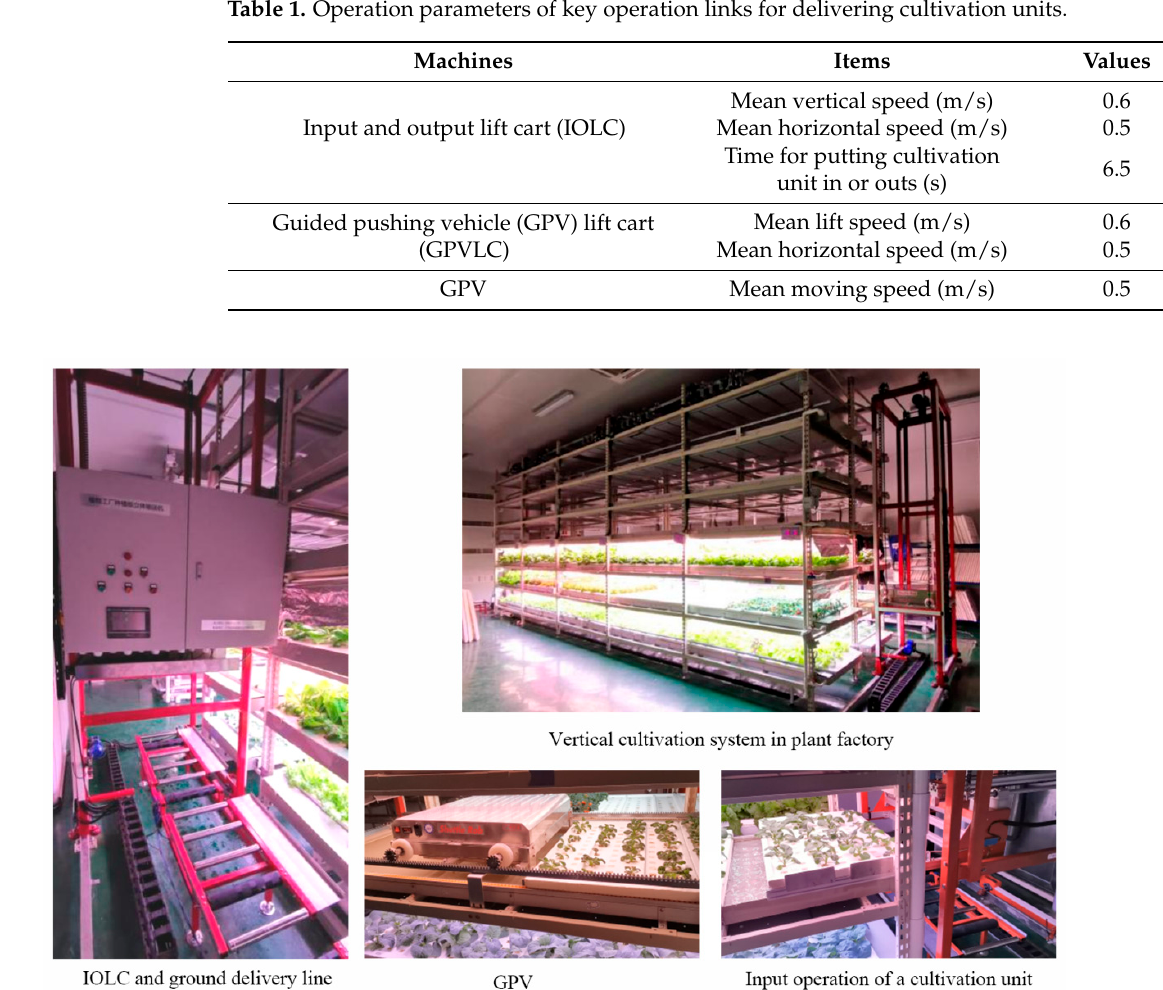
Figure 5. Equipment of the vertical transport system of cultivation units without power inside shelf in plant factory. Table 1. Operation parameters of key operation links for delivering cultivation units.